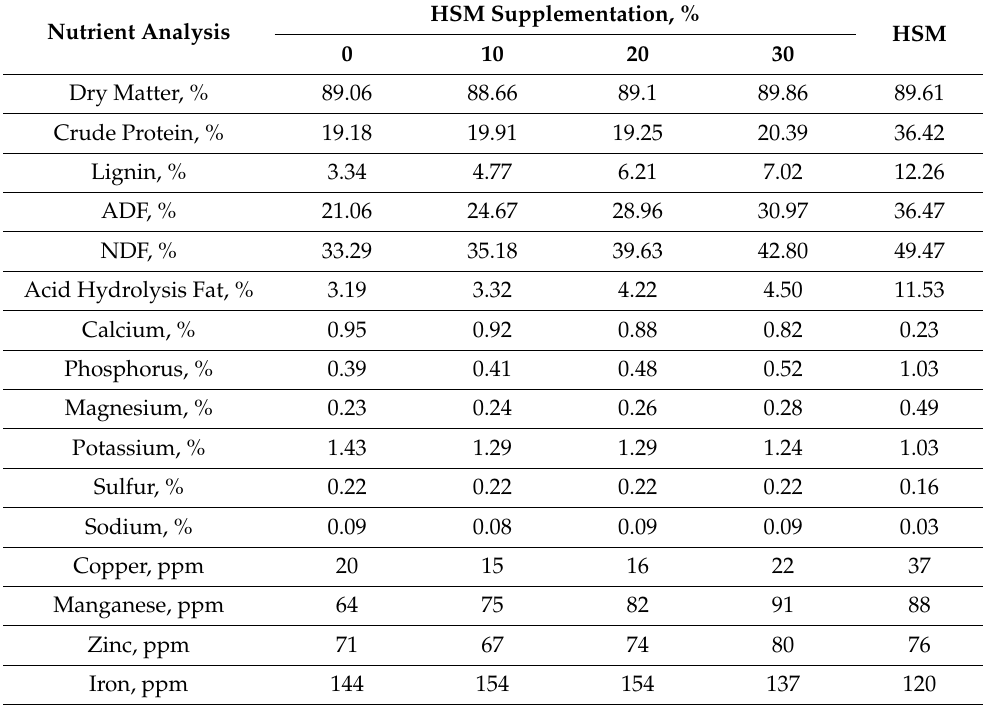
Table 3. Chemical composition of experimental diets and HSM used in experimental diets fed over 60-day feeding period to growing meat